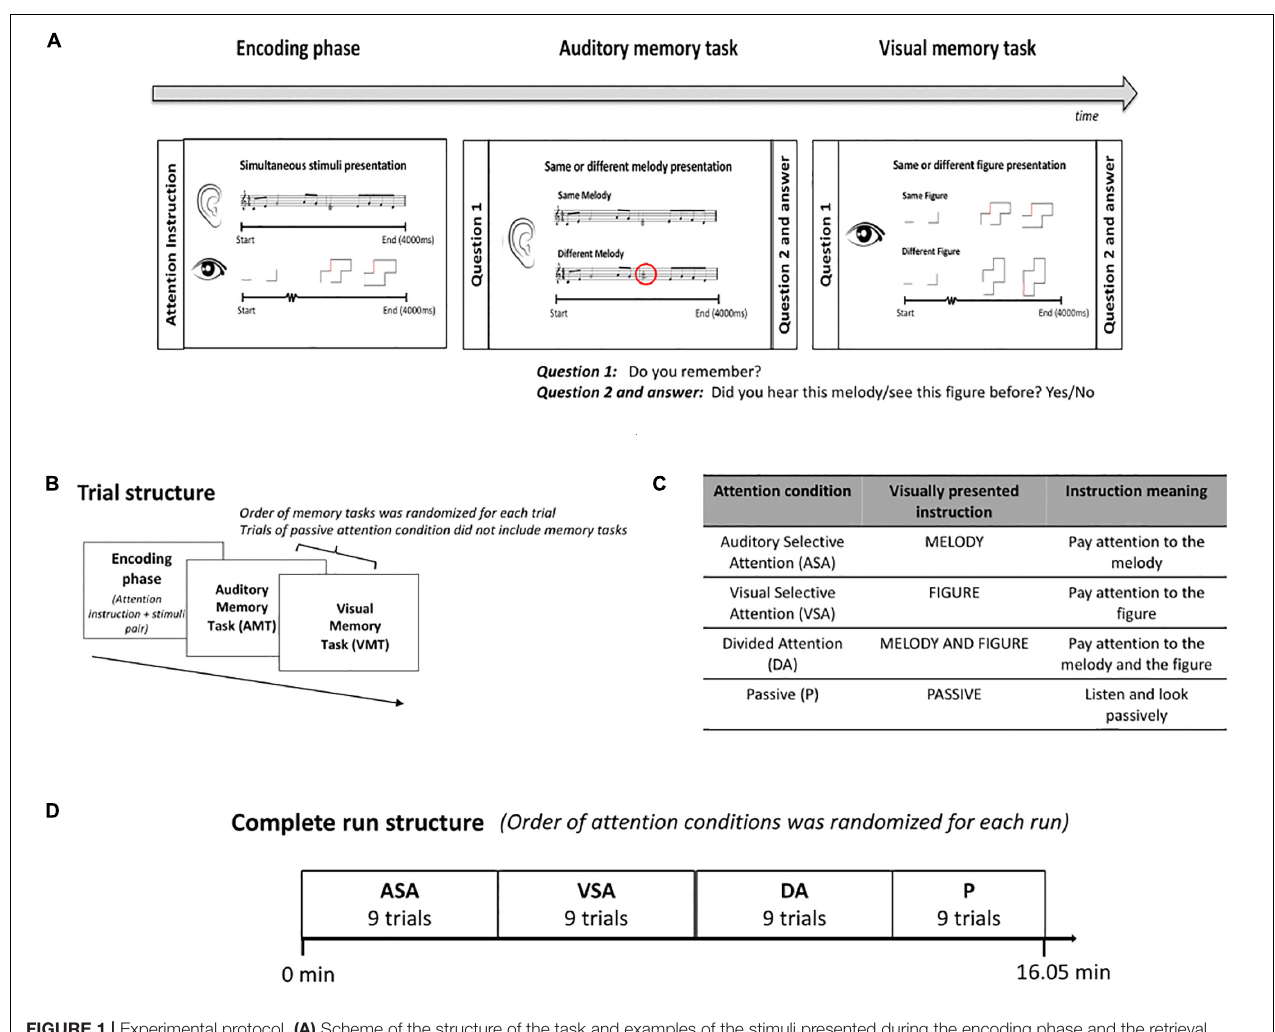
FIGURE 1 | Experimental protocol. (A) Scheme of the structure of the task and examples of the stimuli presented during the encoding phase and the retrieval memory tasks. (B) Trial structure. ASA, VSA, and DA included encoding phase and retrieval memory tasks. Order of memory tasks was randomized for each trial. P only included encoding phase. (C) The attention condition of each trial was given by the instruction presented at the beginning of the encoding phase. (D) Complete run structure. Order of attention conditions was randomized for each run. All participants completed one run of the task in the MRI scanner. ASA, auditory selective attention condition; VSA, visual selective attention condition; DA, divided attention condition; P, passive condition; VMT, visual memory task; AMT, auditory memory